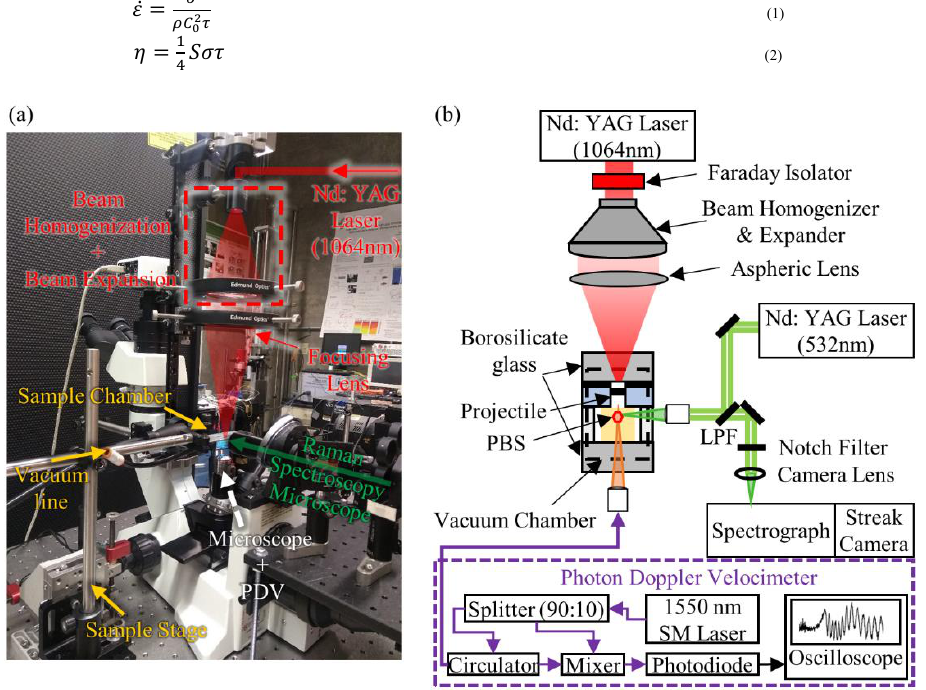
Fig. 1. (a) In-situ Raman spectroscopy and Impact System (b) Schematic of high-speed impact and in- situ Raman spectroscopy system